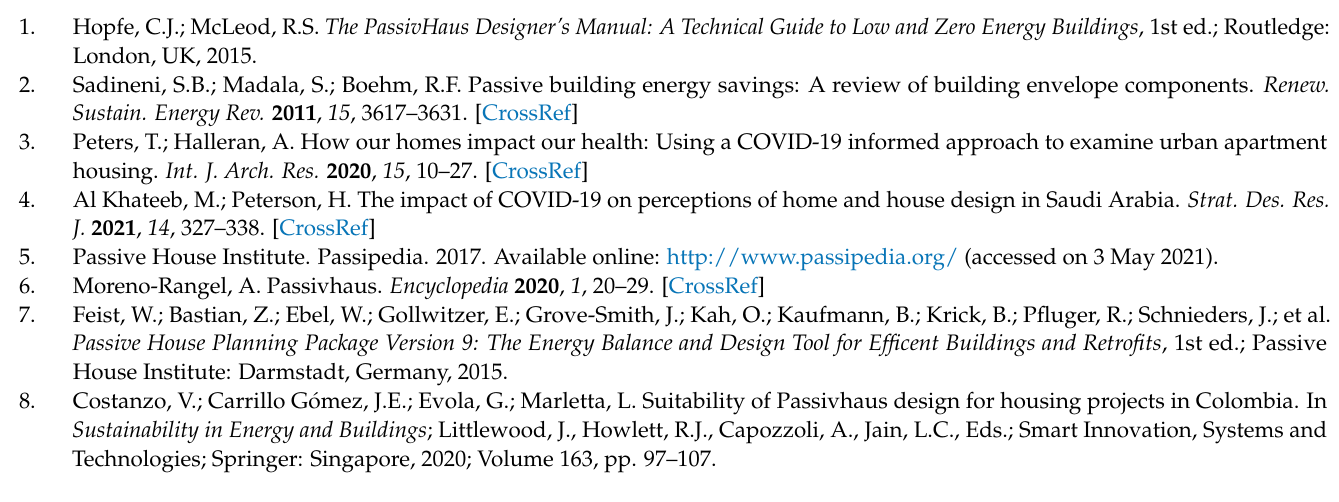
2016, Table S2. Summary of PM2.5 levels in both homes; Table S3. Summary of tVOC levels in both homes; Figure S3. Hourly tVOC levels in the Passivhaus and Standard dwelling’s